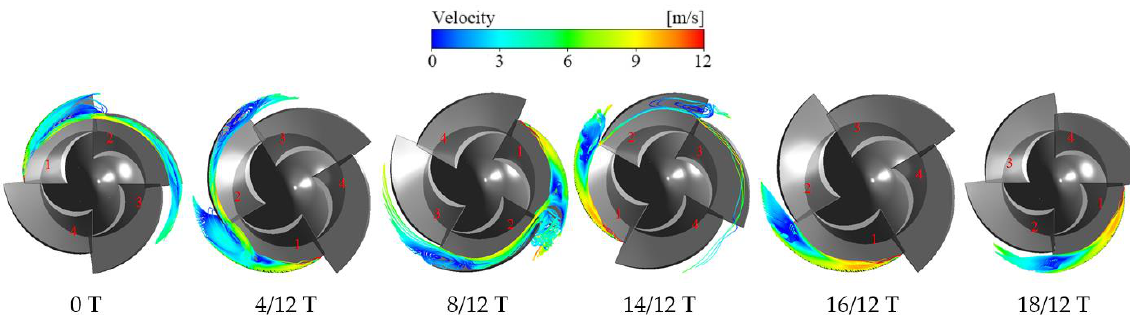
Figure 16. Velocity streamline diagram of leakage flow at different time ( δ = 0.2 mm).